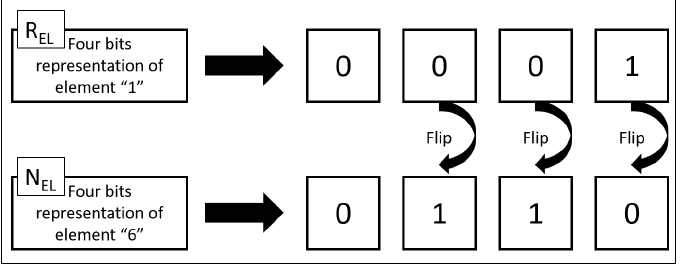
Figure 1. Bits Error Representation. Table 4. Classification of linearly non-equivalent power function, x d based on maximum NL in F 2 8